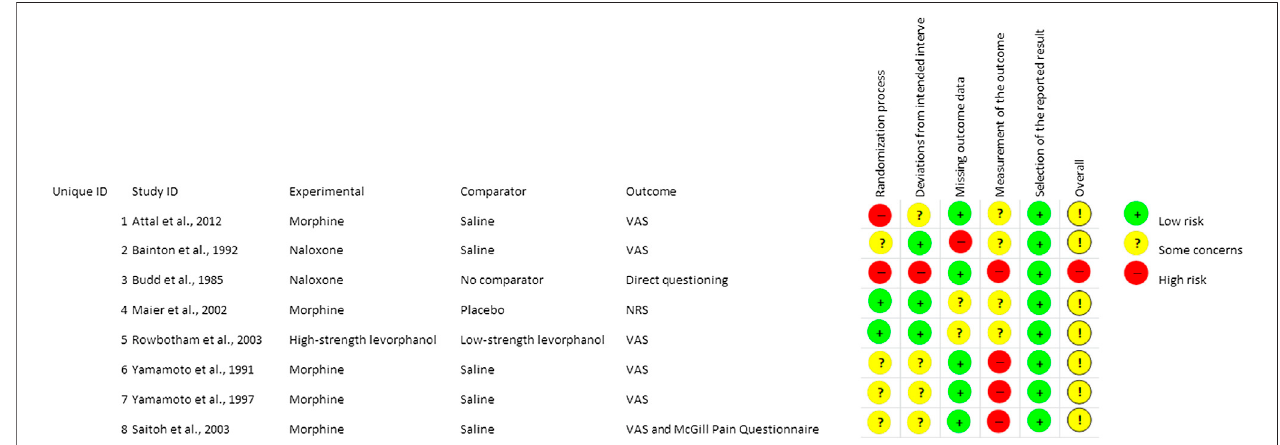
FIGURE2| Summaryofriskofbiasassessment forthestudies included inqualitative analysisfromlowtosomeconcerns andhigh. Themark(+)indicateslowrisk of bias and the mark ( − ) indicates high risk of bias.